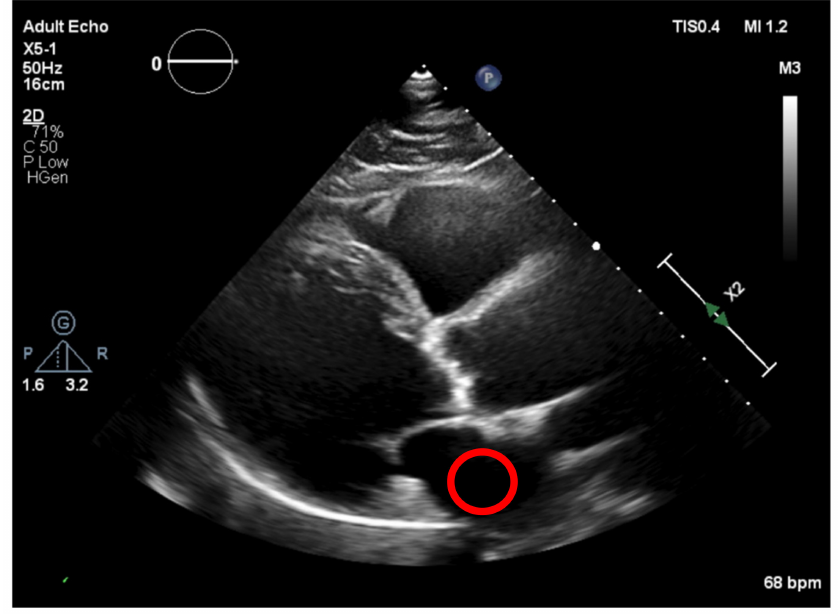
Figure 11. Normalization region (left atrium